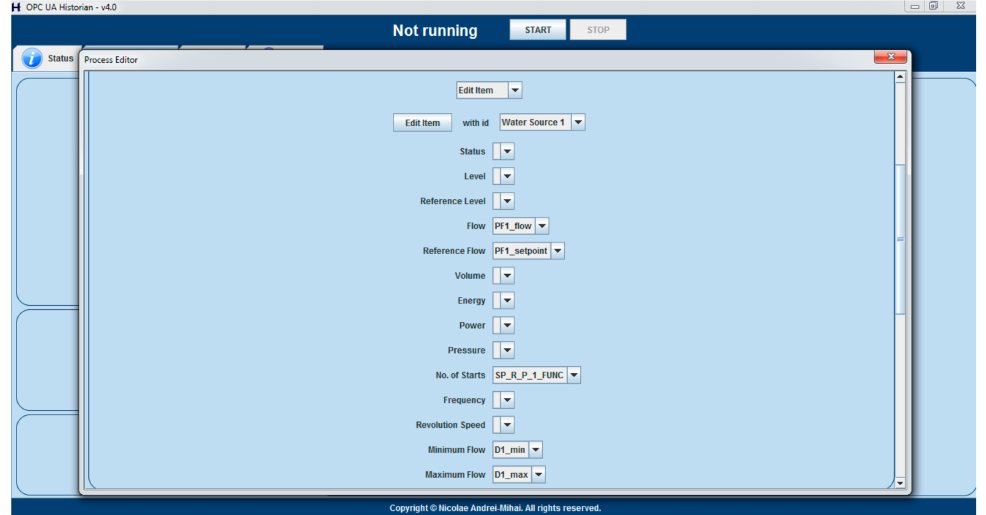
Figure 3. Water source characteristics that must have tags associated, inside the Historian Process Editor, for the currently used process, in order to execute the optimizing